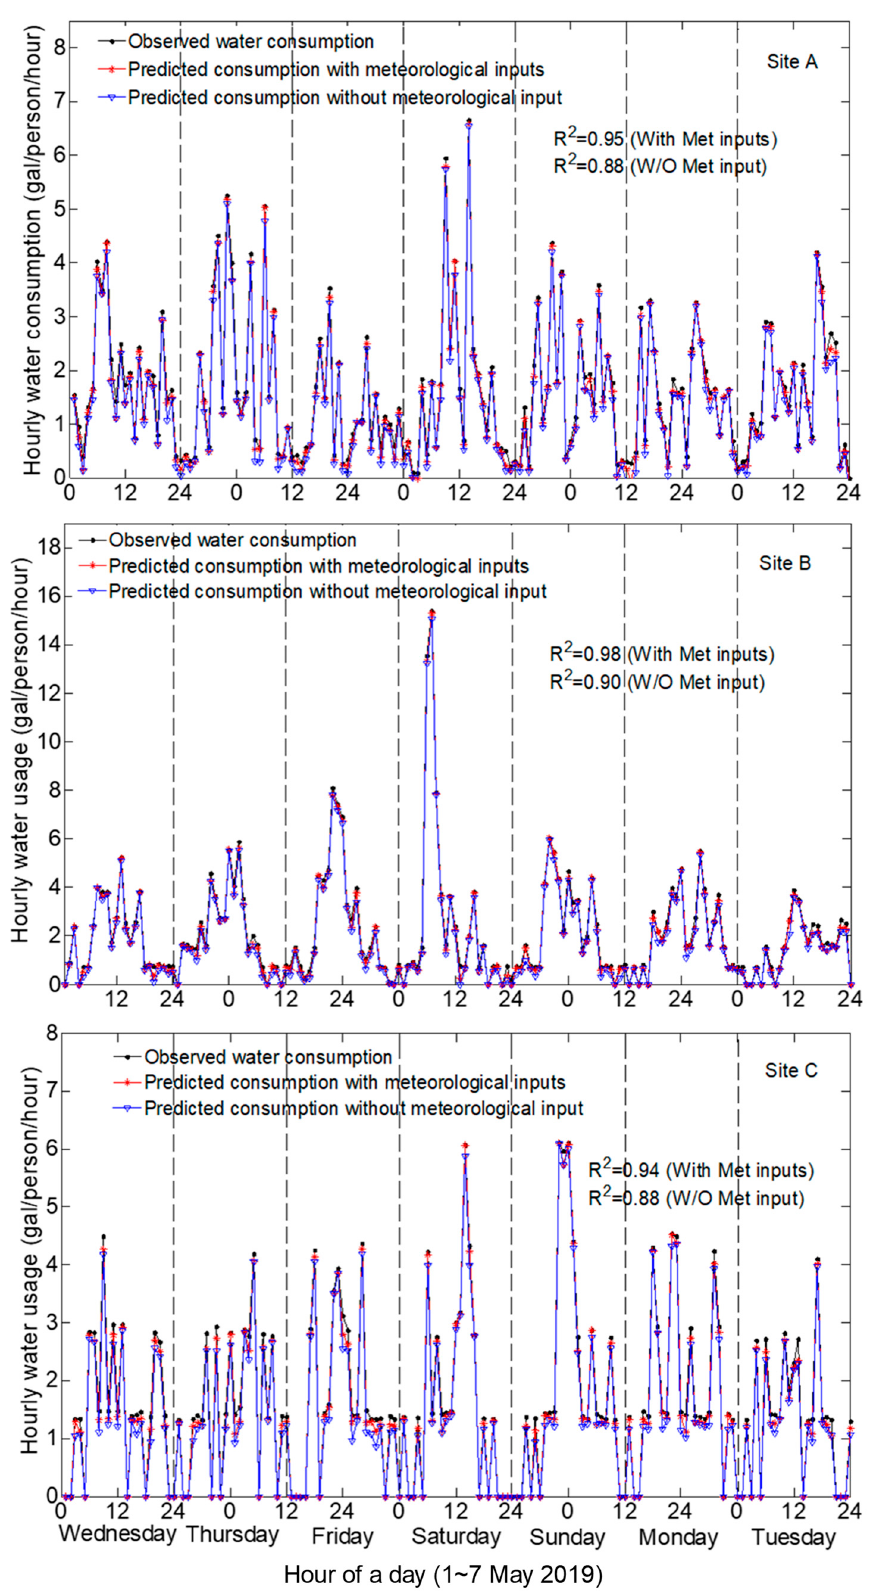
Figure 7. Illustration of the performance of ARMA models for hourly water use (gal/person/day) in Sites A and B , and C for portion of a training dataset trace of the first week in March 2017 (black), with (red) and without (blue) meteorological input for the three study sites. (Met—meteorological; W/O—without).